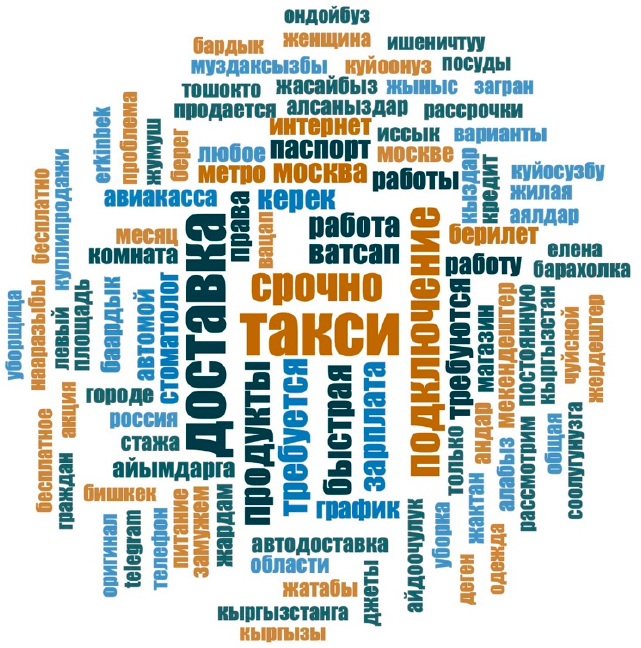
Figure 3. Odnoklassniki Groups: Words Frequency in Posts and Comments.